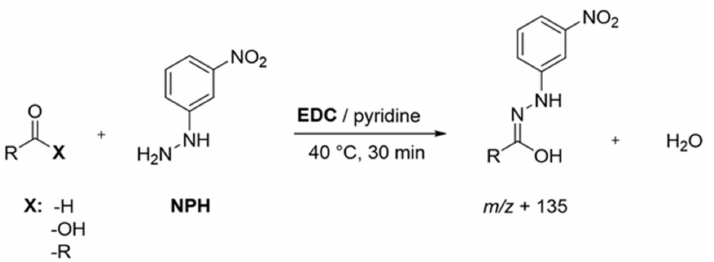
Figure 1. Overview of applied derivatization scheme for the detection of aroma-active compounds. Adapted from [16], with permission from American Chemical Society,